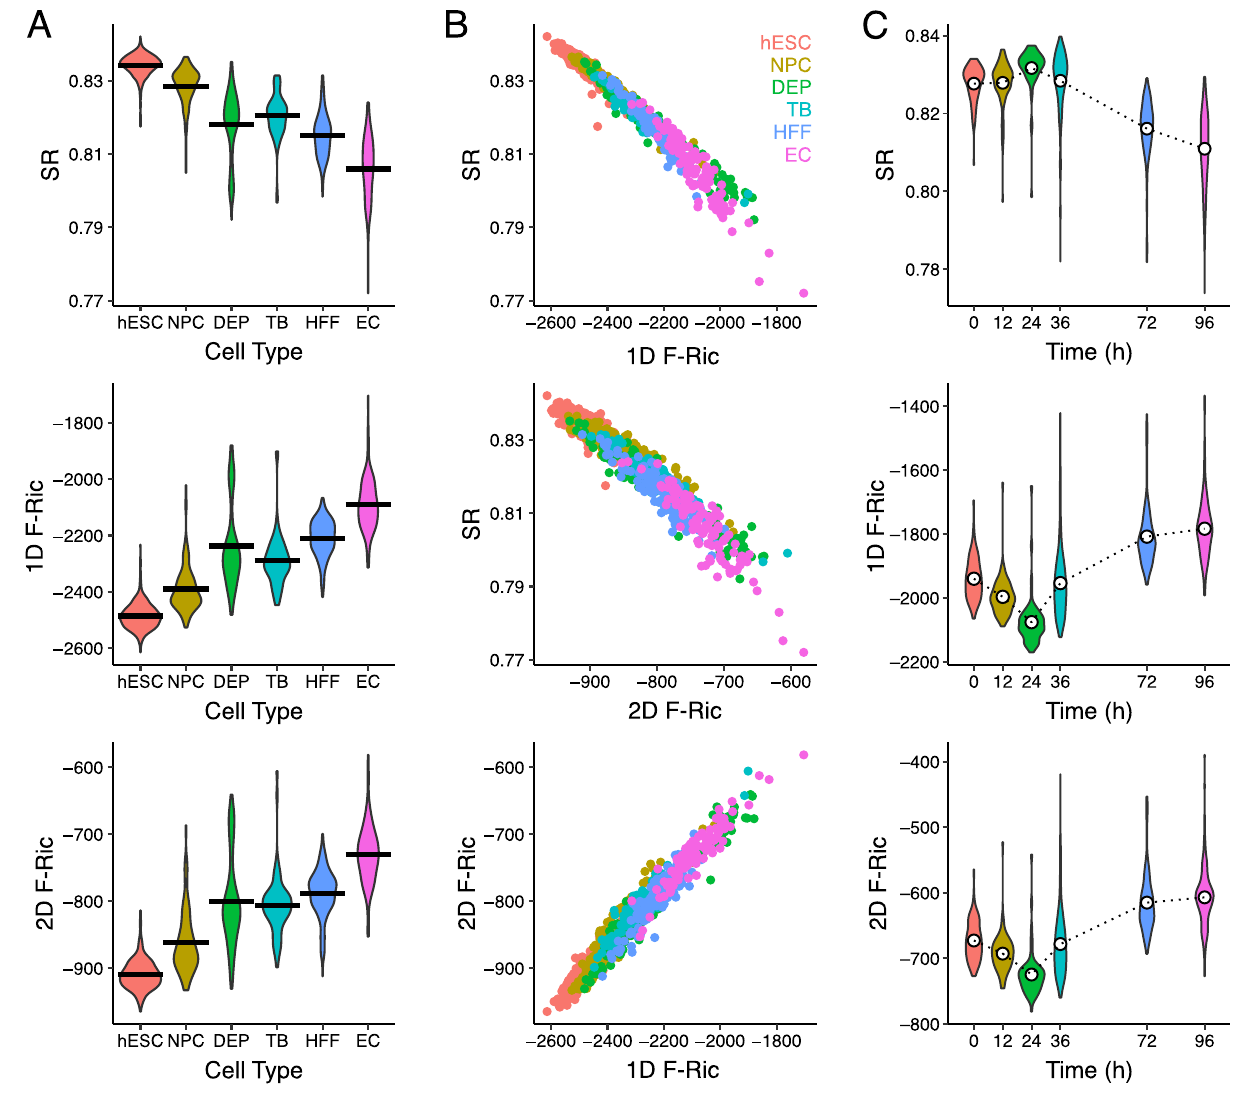
Figure 3. Global PPI network geometry in stem cell differentiation. ( A ) Violin plots of PPI network global average graph entropy (SR) and Forman-Ricci curvature in the 1D graph model (1D F-Ric) and 2D simplicial complex model (2D F-Ric) across 6 increasingly differentiated cell types. ( B ) Correlation plots of SR, 1D F-Ric and 2D F-Ric, colored by cell type. ( C ) Violin plots of SR, 1D F-Ric, 2D F-Ric across time points after induced stem cell differentiation. Dotted lines are means at each time